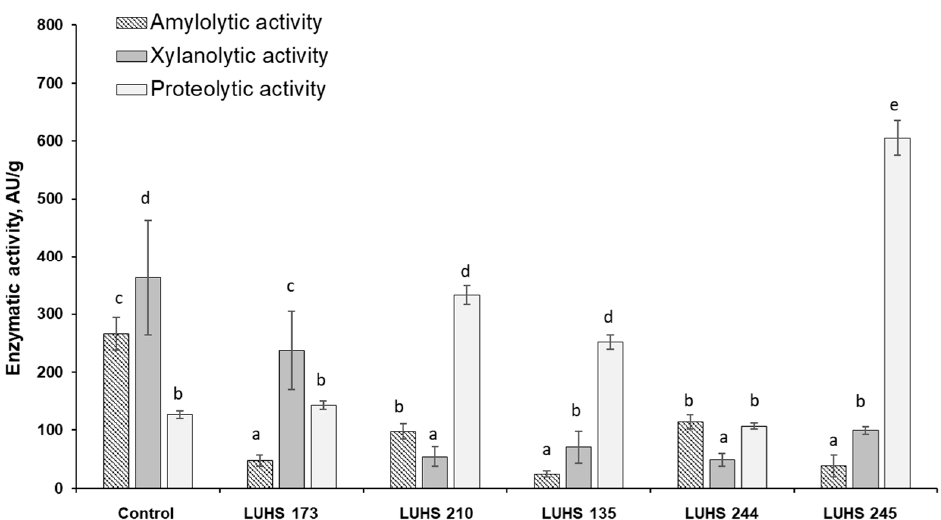
Figure 4. Changes in enzymatic activities (amylolytic, xylanolytic, and proteolytic) of LAB strains (LUHS 173, LUHS 210, LUHS 135, LUHS 244, LUHS 245-barley wholemeal samples fermented with Levilactobacillus brevis LUHS173, Lacticaseibacillus casei LUHS210, Lactiplantibacillus plantarum LUHS135, Lacticaseibacillus paracasei LUHS244, and Liquorilactobacillus uvarum LUHS245, respectively) during fermentation of the least contaminated sample BWP2 (AU—activity units). a–e Mean values denoted with different letters indicate significantly different values between the columns ( p ≤ 0.05).